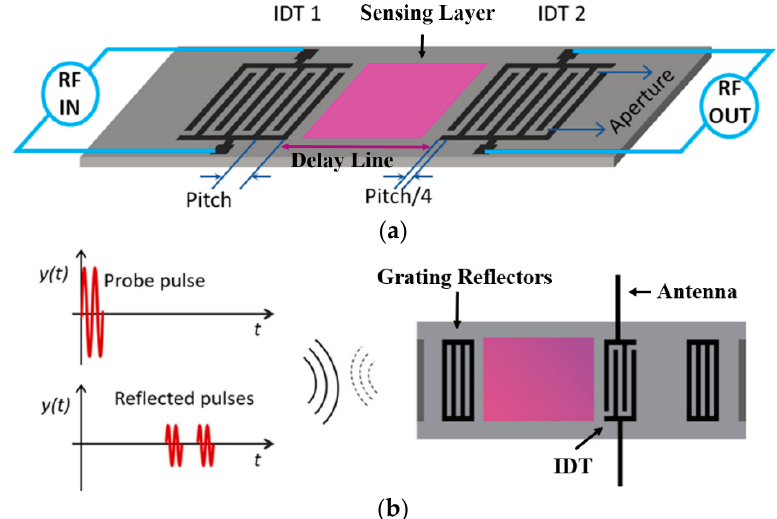
Figure 20. Schematic of ( a ) a surface acoustic wave (SAW) sensor with a coated sensing layer on the delay line and ( b ) a functionalized SAW sensor interrogated wirelessly [228,229].